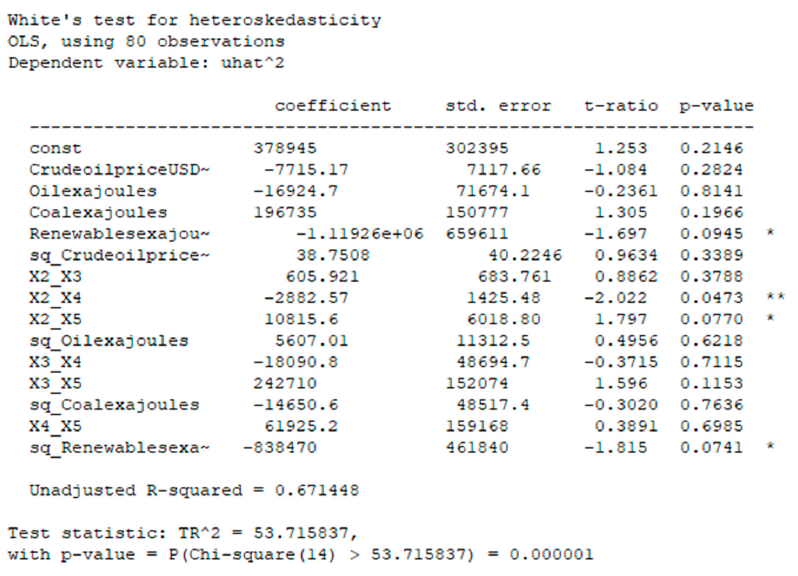
Figure 4. Testing the model for heteroscedasticity.